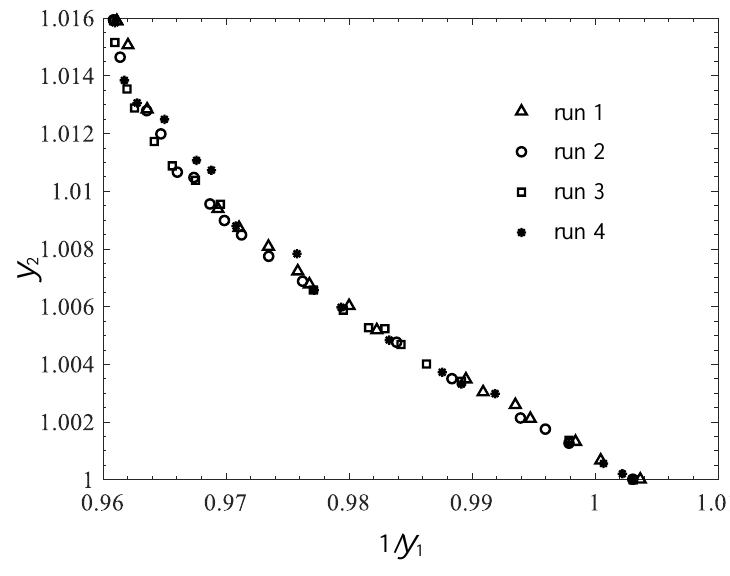
Figure 10. Distribution of Pareto fronts for four runs. Table 3. The structural parameters corresponding to noninferior solutions. Table 2. Parameters associated with gamultiobj.